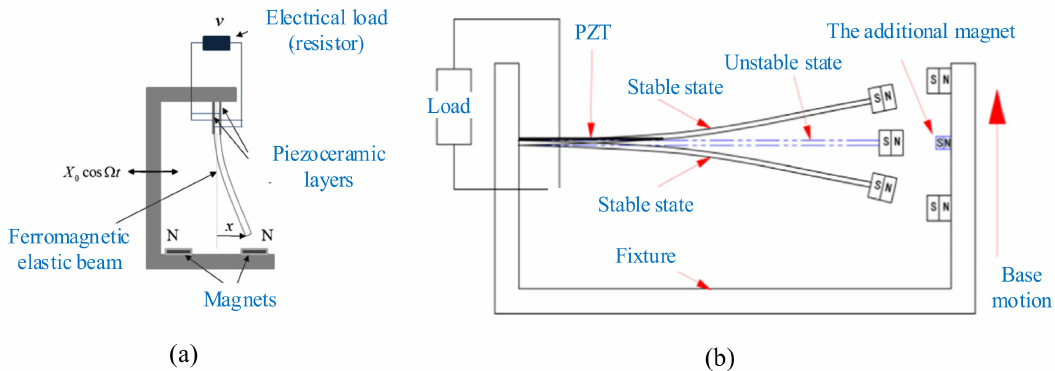
Figure 8. The bistable harvesters with magnetic attraction. ( a ) The piezomagnetoelastic energy harvester (reproduced